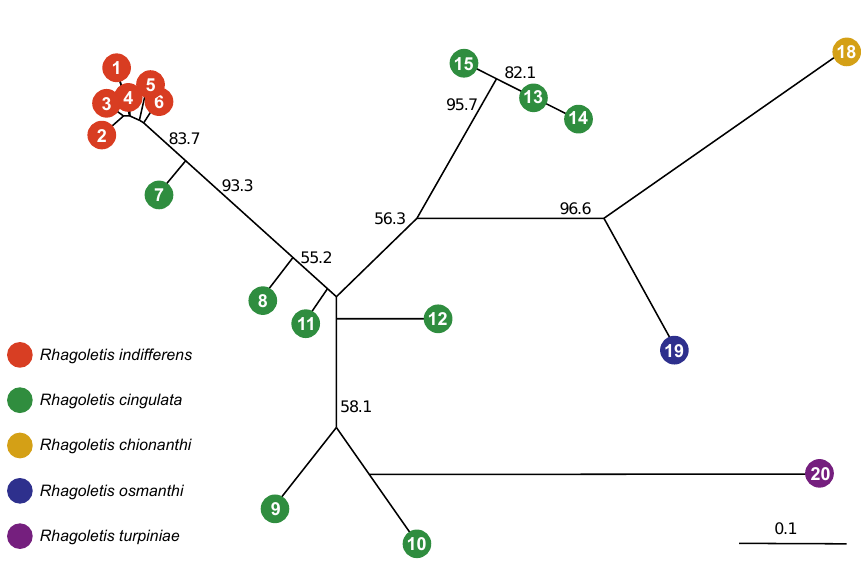
Figure 2. Neighbor-joining genetic distance network for R. cingulata group flies across North America based on 21 microsatellite loci. Also shown are bootstrap support levels for nodes based on 10,000 replicates. A Nei’s genetic distance of 0.1 is indicated by the scale bar. Table 2. Mean overall Nei’s genetic distances ( ± s.e., where appropriate) between R. cingulata species group populations involving comparisons at varying levels of biological organization and geographic structure across North America. n = number of pairwise genetic distance estimates in the given comparison.